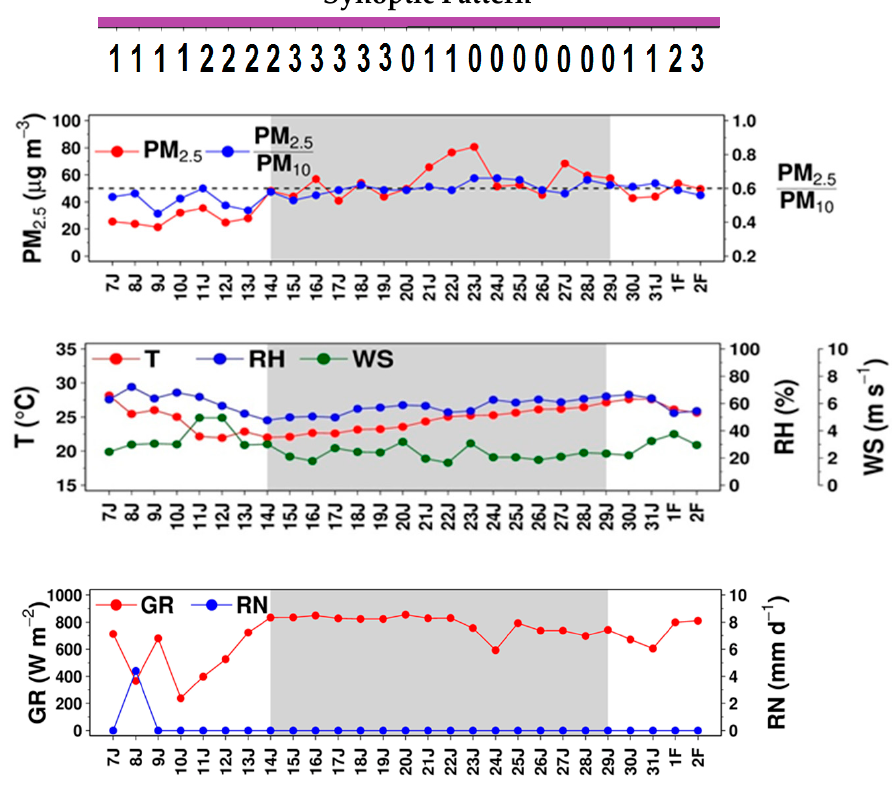
Figure 3. Daily PM 2.5 , PM 2.5 / PM 10 (at station P61) and other meteorological variables during EP1.